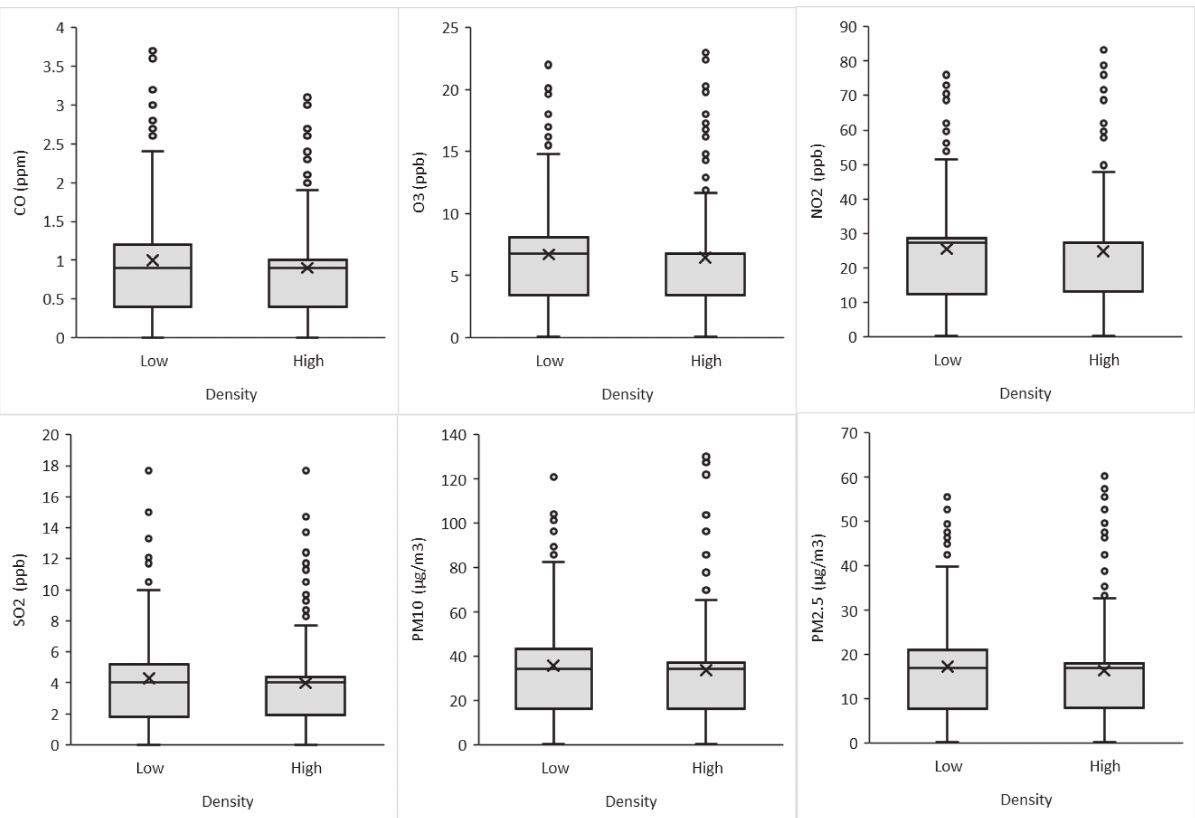
Fig. 1 Comparison of participants ’ exposure to ambient air pollutants with high and low mammographic breast density. The P-values of the t-tests were: P-value = 0.054 (CO), P-value = 0.404 (O 3 ), P-value = 0.601 (NO 2 ), P-value = 0.125 (SO 2 ), P-value = 0.233 (PM 10 ), and P-value = 0.295 (PM 2.5 ). Further information is presented in Supplementary Table